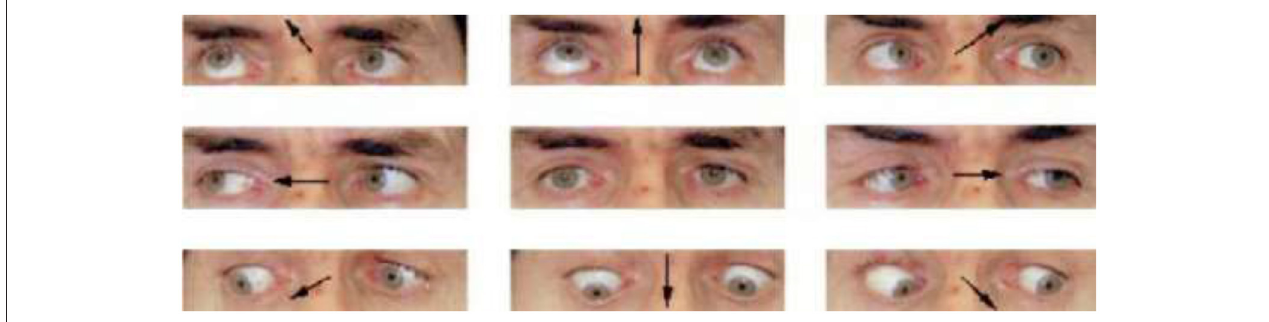
FIGURE 1 | Different appearance of the eyes (Bejjani et al.,